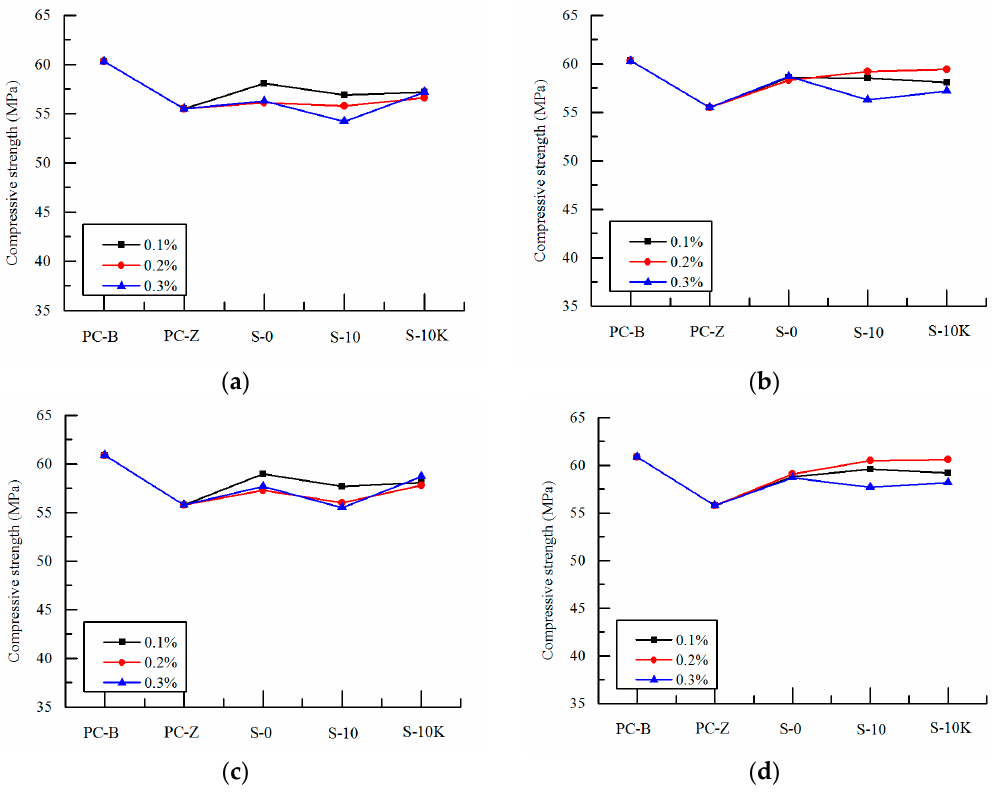
Figure 5. Effects of SAP on compressive strength of concrete at later ages: ( a ) 90 days SAP-a; ( b ) 90 days SAP-b; ( c ) 120 days SAP-a; ( d ) 120 days SAP-b, S-10 and S-10K are pre-absorbed, and S-0 is non-absorbed.